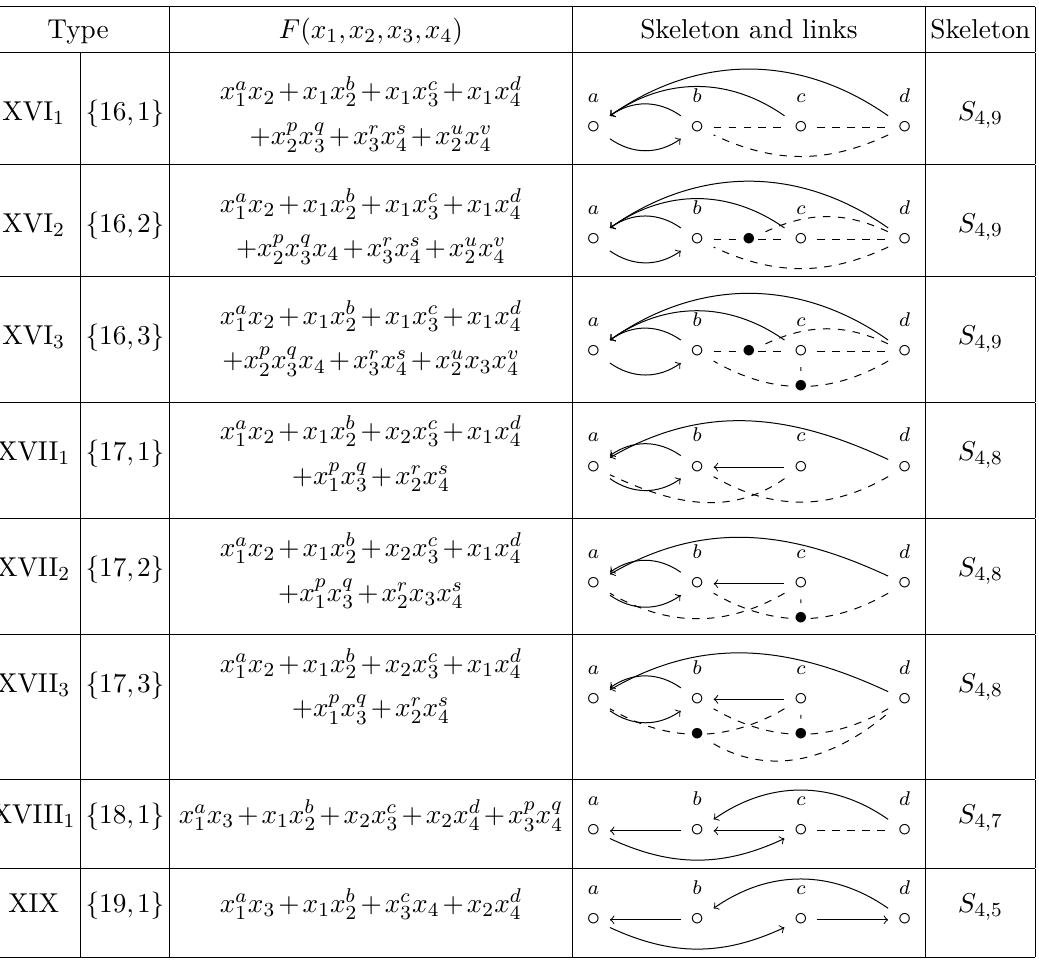
Table 3 . The KS-YY classification of isolated hypersurface singularities in C 4 : types XVII to XIX.